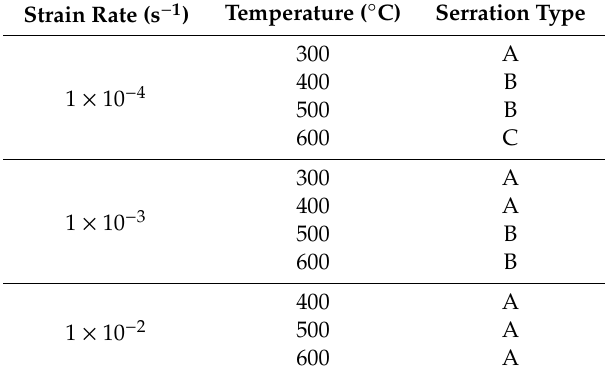
Table 5. Summary of the serration type exhibited by the CoCrFeMnNi HEA during tension at